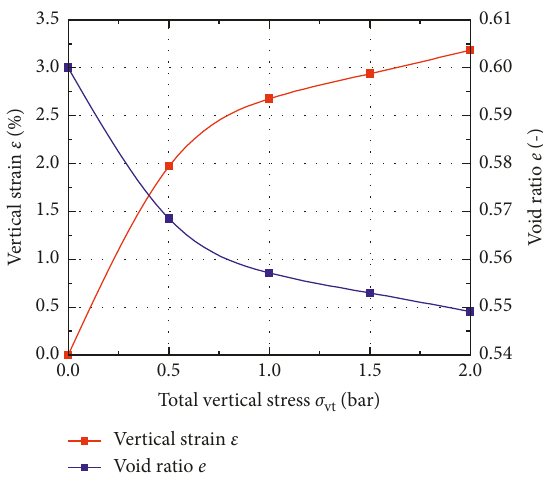
Figure 4: Stress-strain and e - p curves for standard sand with a moisture content of